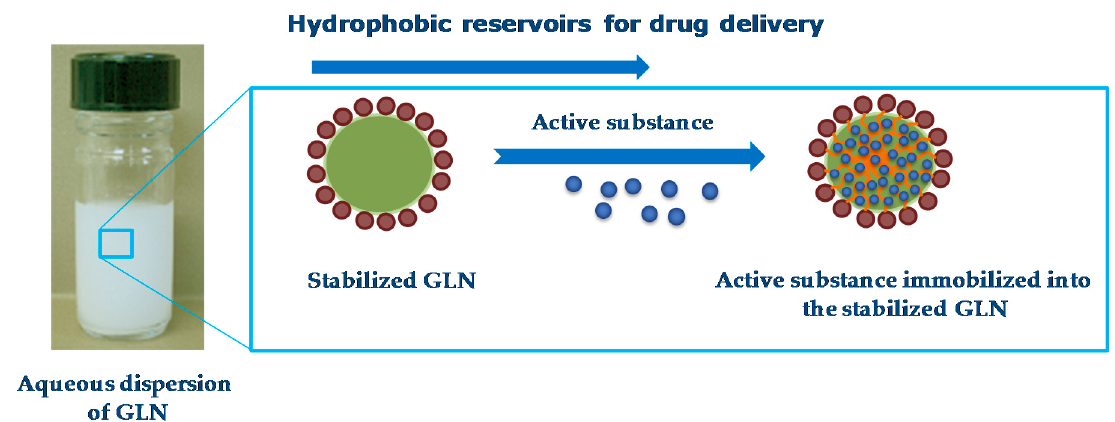
Figure 12. Representation of the drug delivery ability of GLN.